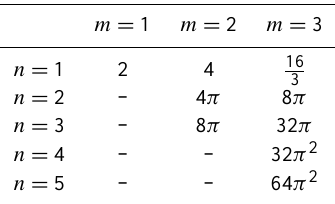
Table 1. Kernel as a function of non-dimensional radius ρ = | L − 1 x | ≥ 0 for different values of the dimension n and the high- est derivative m .